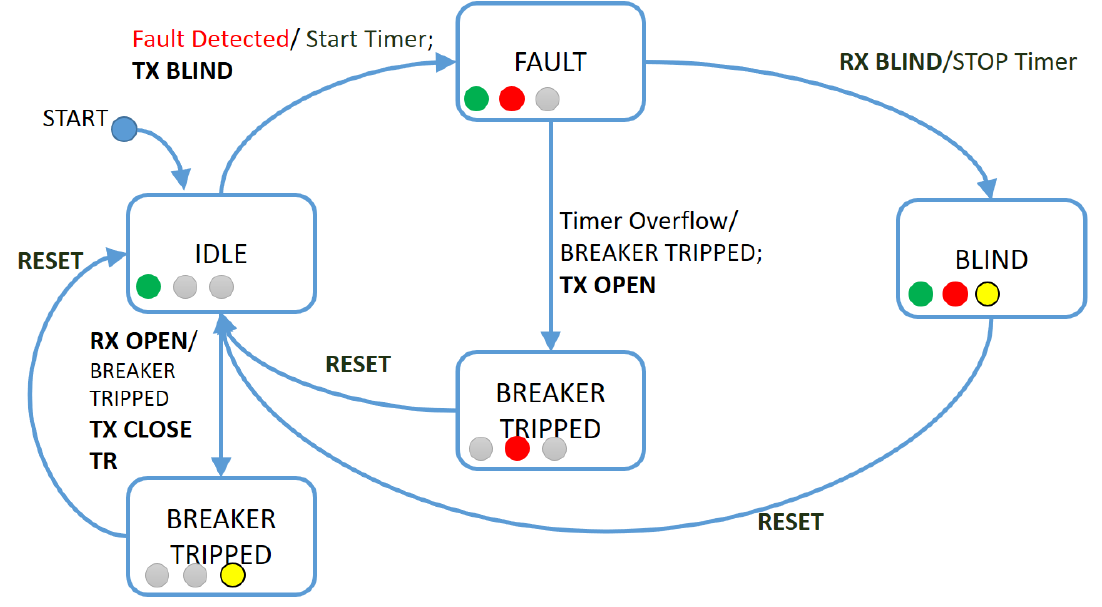
Figure 5. State machine implemented on the microcontroller of a